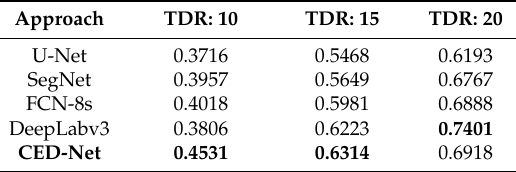
Table 9. Results using true detection rate (TDR) variants, the number next to the TDR represents di ff erent threshold levels (bold number represents the best results in the